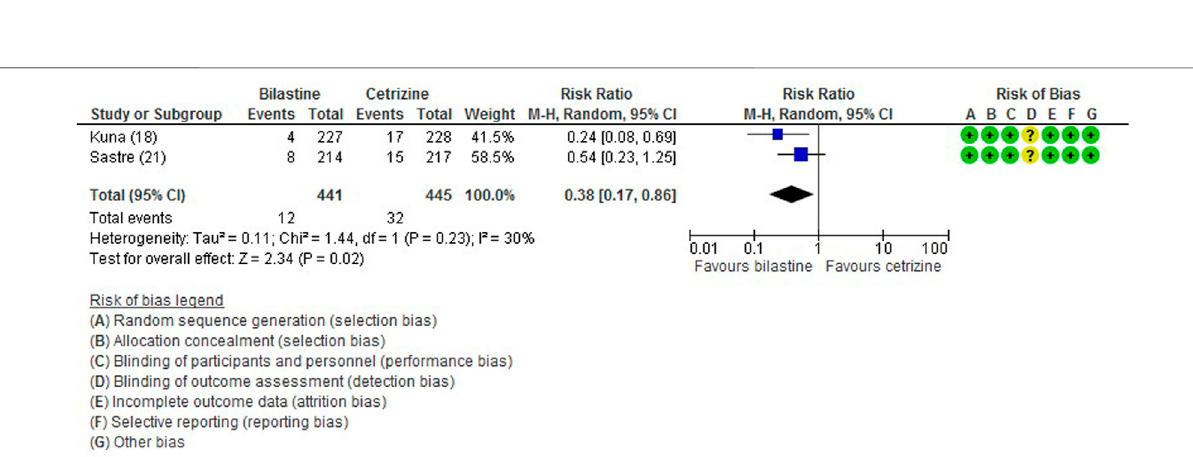
Frontiers in Pharmacology |